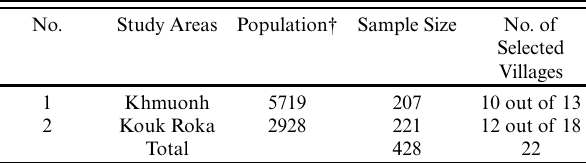
Table 1 . Research sample